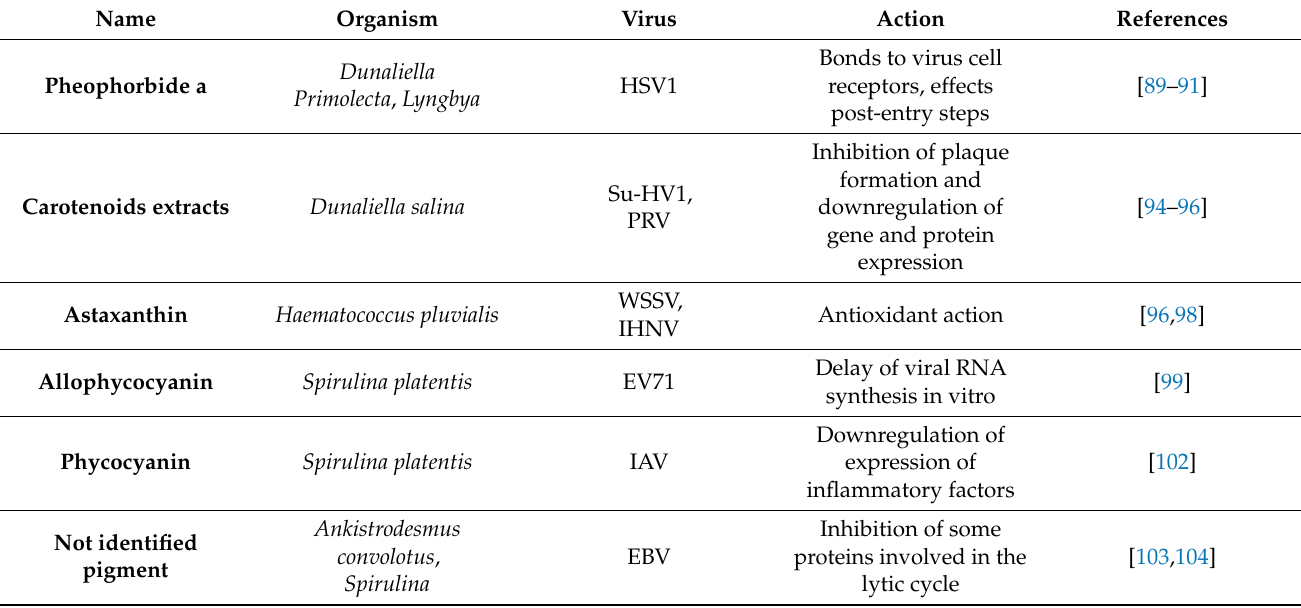
Table 3. Microalgae pigments and derivatives with antiviral